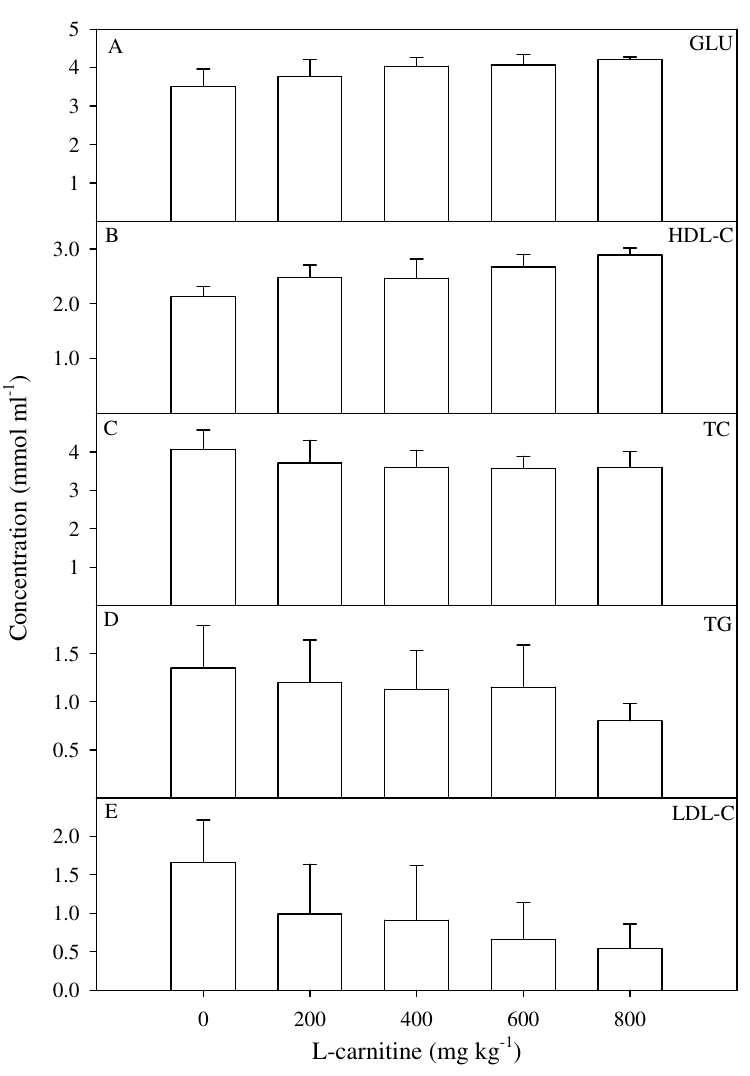
FIGURE 2. Effects of L-carnitine levels on (A) GLU, (B) HDL-C, (C) TC, (D) TG, and (E) LDL-C of the new GIFT strain of juvenile Nile tilapia. Error bars represent one standard deviation of each